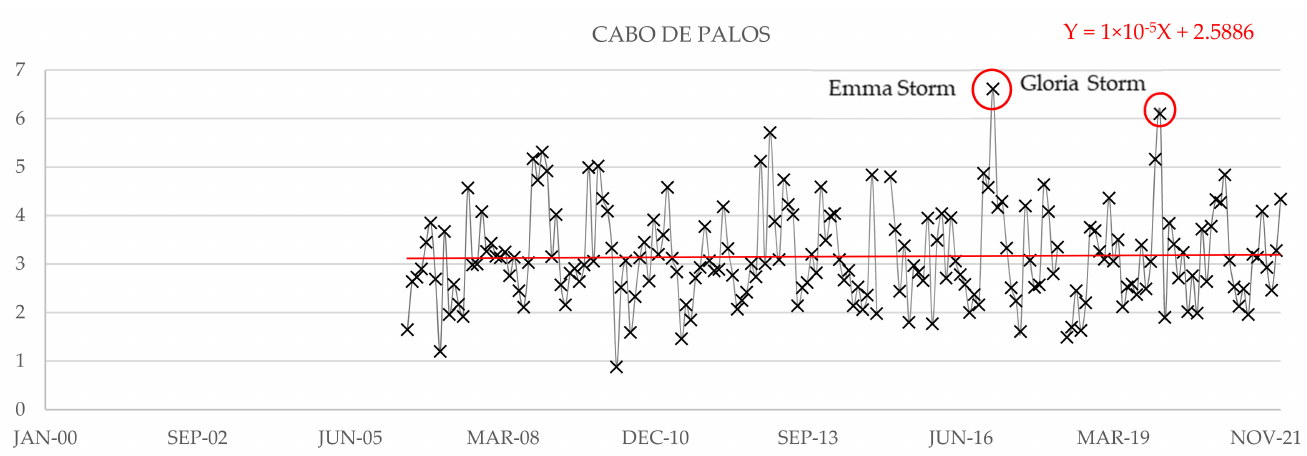
Figure 5. Evolution of Hs maxima in Cabo de Gata.